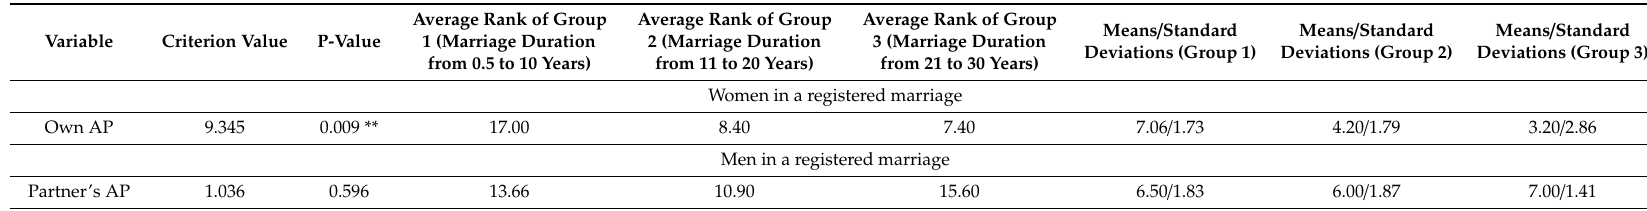
Table 4. Results of a comparative analysis of attitude toward own AP in women and attitude toward AP of the wife in men with di ff erent durations of the registered